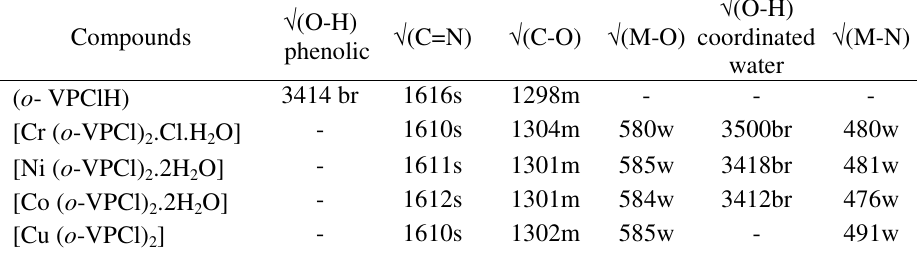
Table 4. IR spectral data of ligand and its metal